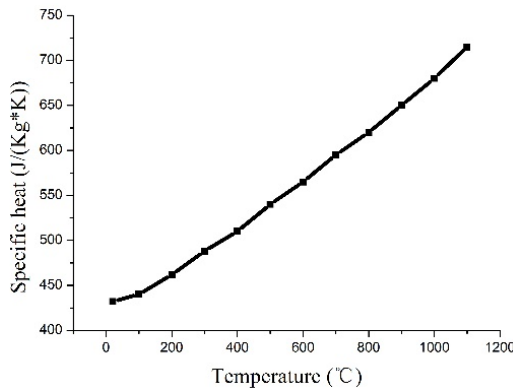
Figure 6. Conductivity of Inconel 718.